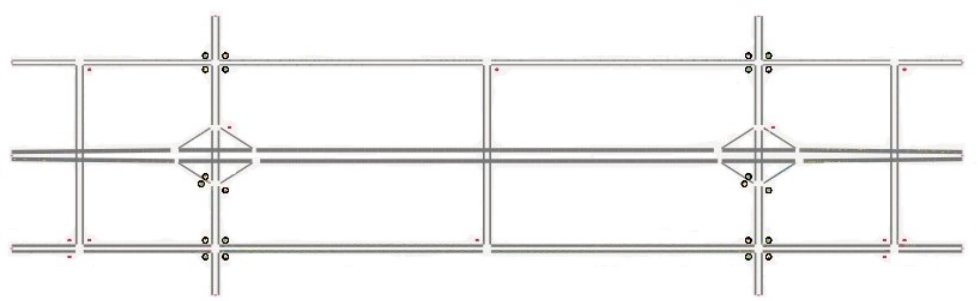
Figure 6. QNET network